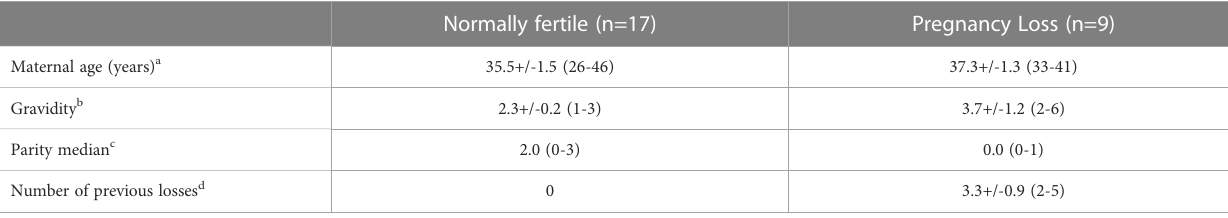
TABLE 1 Characteristics of non-pregnant